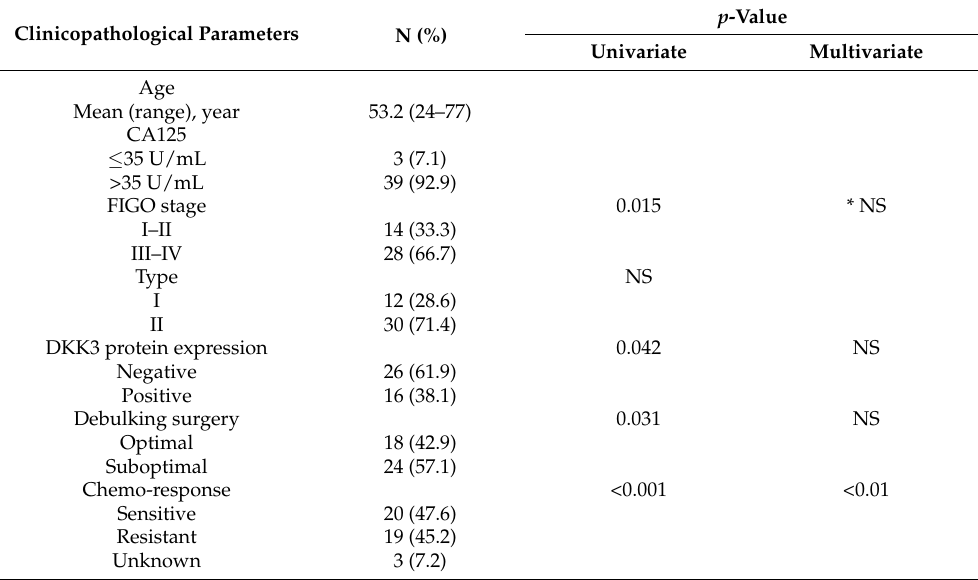
Table 2. Clinicopathological parameters and disease-free survival analysis of prognostic factors in 42 patients with serous